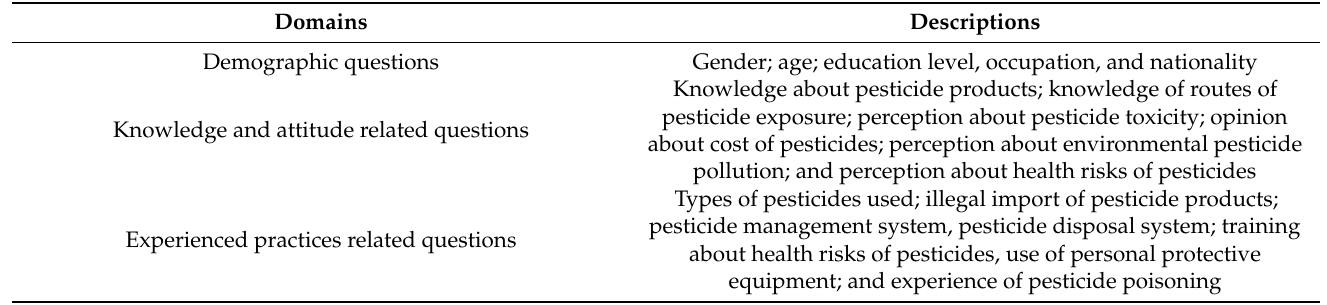
Table 1. Overview of the questions included in the questionnaire used in the study.